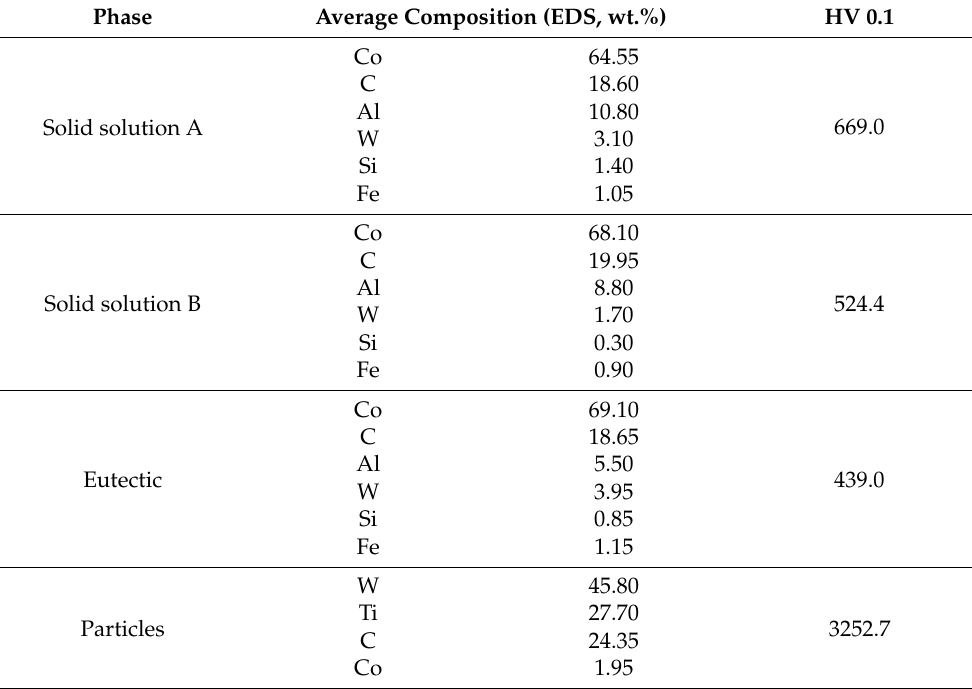
Table 5. Results of the phase composition of the produced Co70W12Al15 alloy analyzed by X-ray fluorescence diffractometer (XRD) and microhardness HV